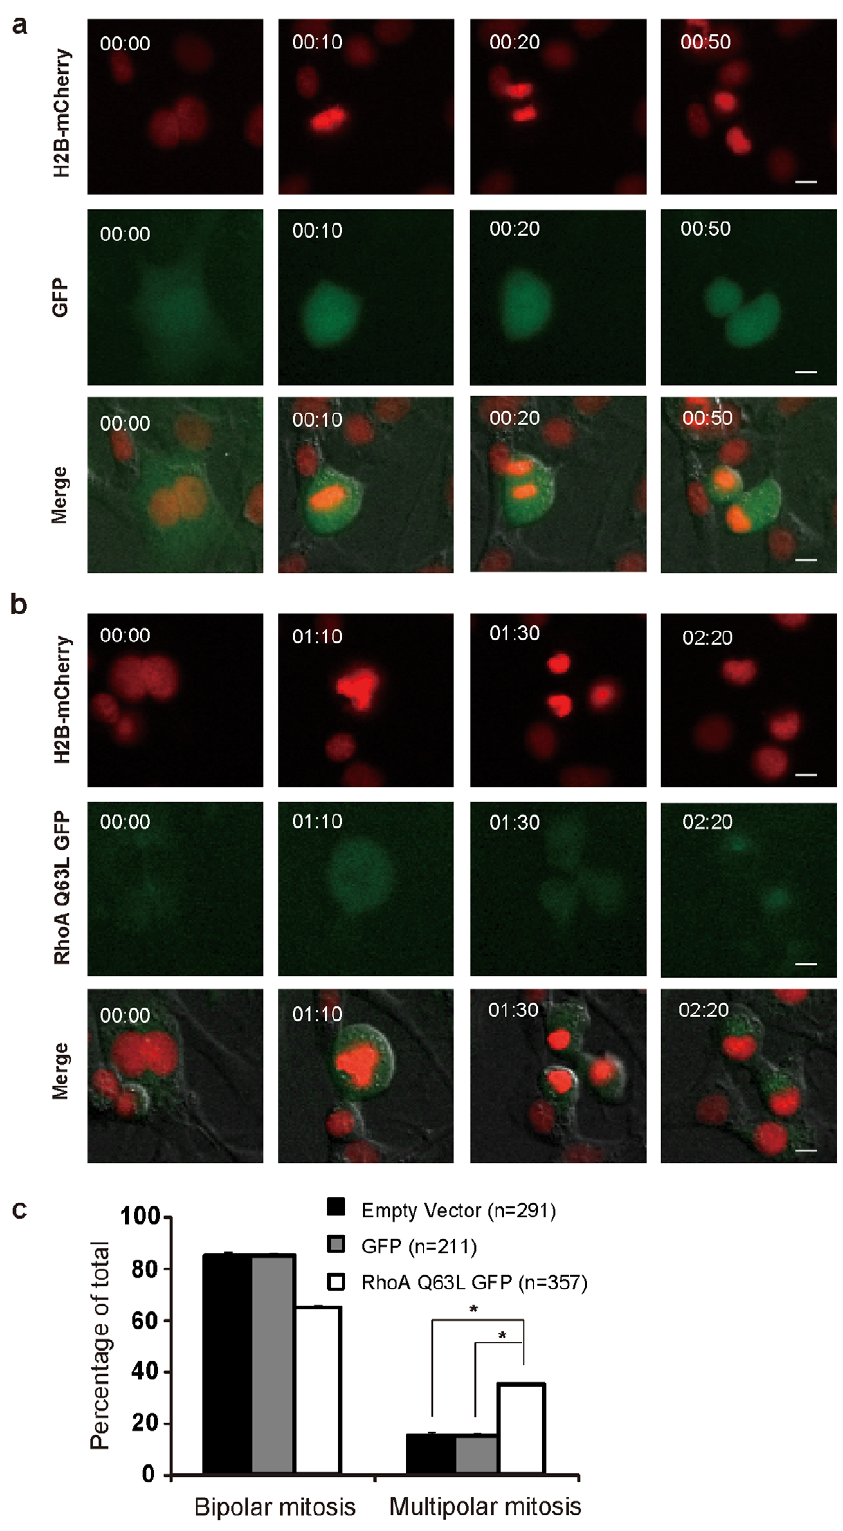
Figure 5. Increased RhoA activity increases multipolar mitosis in tetraploid cells with wild type p53. Mitotic polarity of cells was examined by live cell imaging after transient transfection of indicated plasmids followed by 1.5 m g/ml Cyto-B treatment for 12 h. (A,B) Selected serial images from time-lapse records are examples of: (A) Bipolar mitosis of a 3T3 cell expressing EGFP as a control; (B) Multipolar mitosis of a 3T3 cell expressing EGFP-RhoA-Q63L. In each image series, the upper panels (red) indicate chromosomal material, the middle panels (green) show whole cell distribution of EGFP or cytoplasmic distribution of EGFP-RhoA-Q63L respectively, and the bottom panels show images merged with red channel, green channel and differential interference contrast channel. Bar=10 m m. Time counted from cell entering mitosis is presented as h:min at top-left.